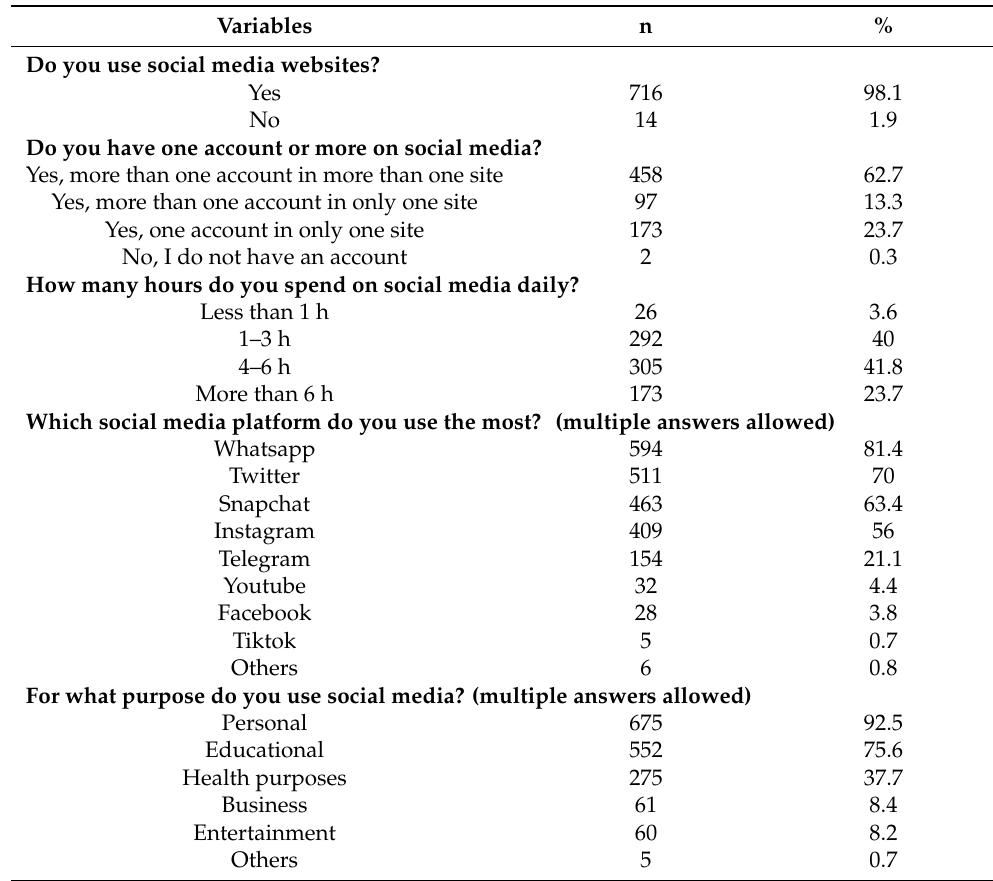
Table 2 details the pattern and frequency of our respondent’s SM use. Almost all students, 716 (98.1%), use SM with 458 (62.7%) of them having more than one account in multiple sites. About three quarters of the respondents spend between 1–3 h and 4–6 h on SM daily; 292 (40%) and 305 (41%), respectively. WhatsApp ranked number one most used SM platform, indicated by 594 (81.4%) students, followed by Twitter (511, 70%), Snapchat (463, 63.4%), and Instagram (409, 56%). Table 2. Social media use by study participants (n =